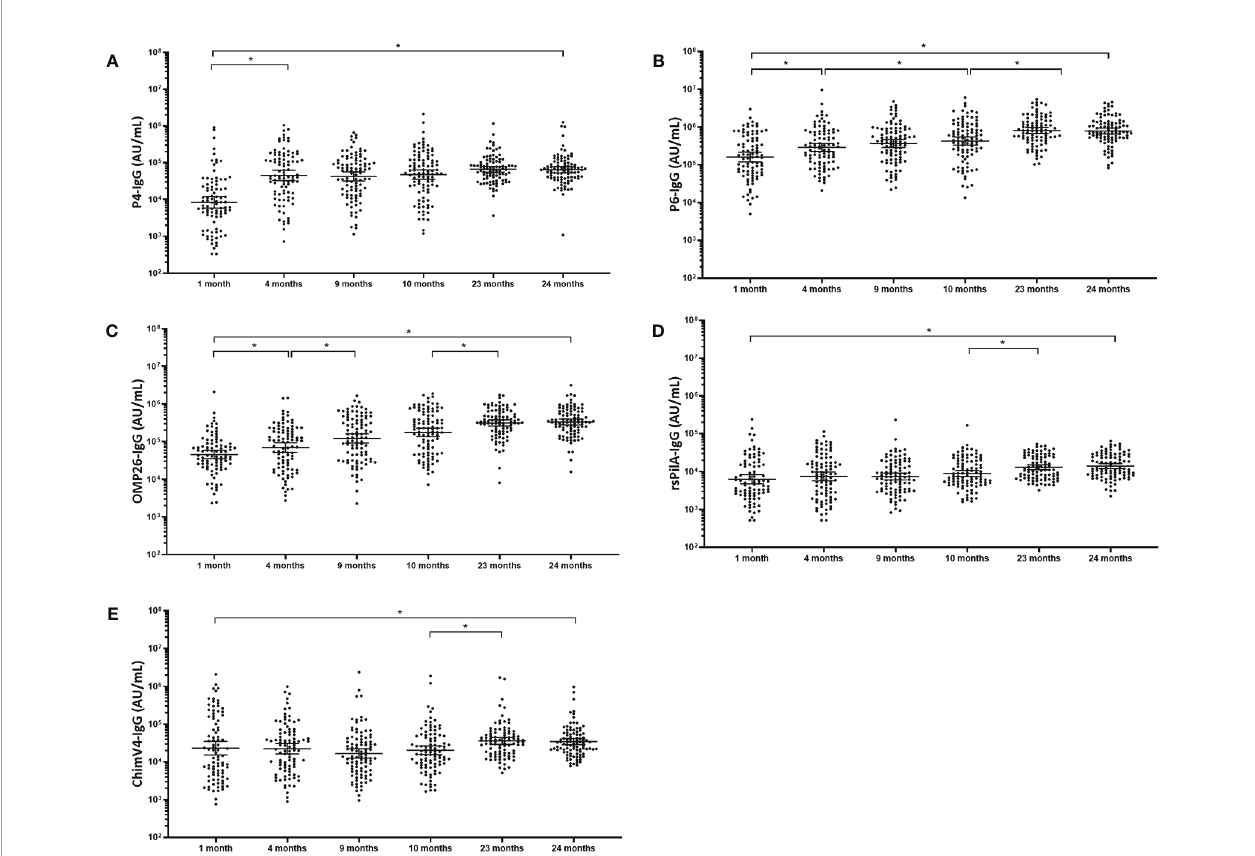
FIGURE 2 | Serum IgG antibodies against NTHi antigens increase gradually over the fi rst 2 years of life. Each point represents the serum IgG titre against NTHi antigens for a child in AU/mL (A) P4, (B) P6, (C) OMP26 and (D) rsPilA (E) ChimV4. The horizontal bars depict the geometric mean titre (GMT) of IgG at each time- point +/- 95% CI. PD, Protein D; P4, Protein 4; P6, outer membrane protein 6, OMP26, outer membrane protein 26; rsPilA, recombinant soluble pilus A protein; ChimV4, chimeric vaccine antigen 4 (rsPilA and P5). *p-value <0.05, Statistical analyses were conducted logarithmically transformed data. All children had measurable antibody